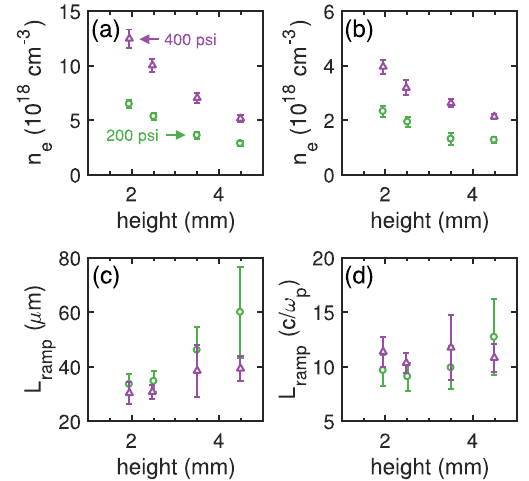
FIG. 3. Characteristics of the down ramp as a function of the plasma height. (a) Upper shelf density of the down ramp. (b) Lower shelf density of the down ramp. (c) Ramp length in real units. (d) Ramp length in normalized units. Each dot is an average, and the error bar represents the standard deviation of 20 shots. The purple triangles (green circles) are measured under a backing pressure of 400 (200)